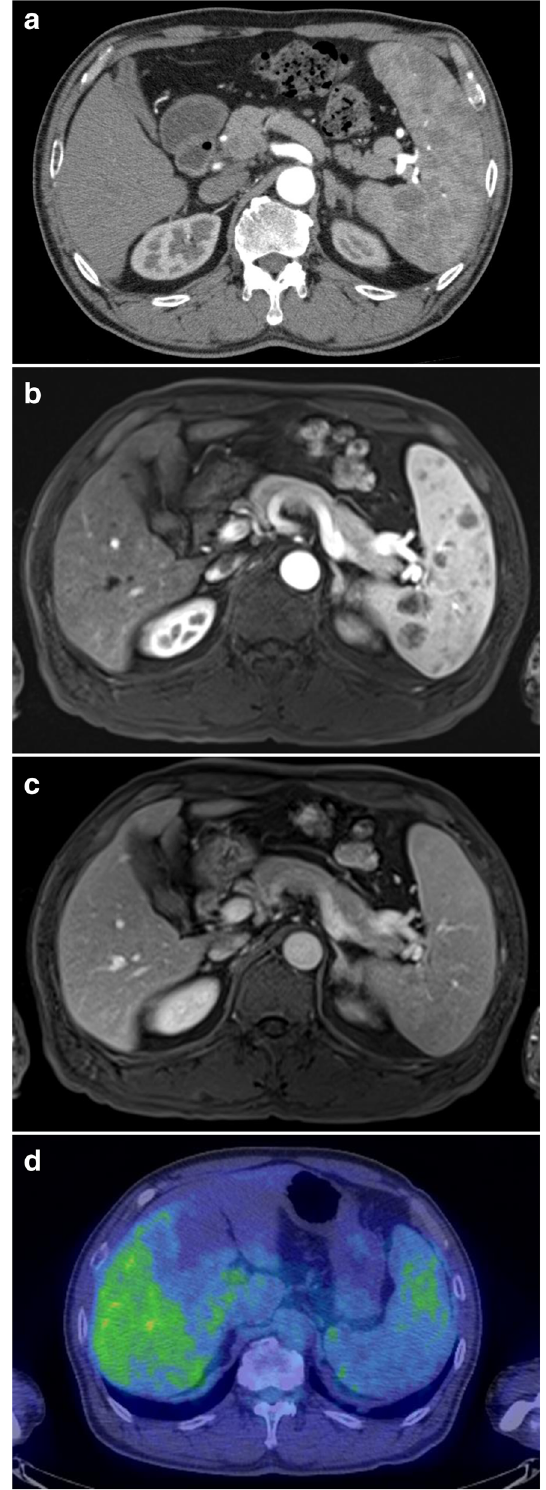
Fig. 3 a Macroscopic findings. A specimen showing splenomegaly (spleen size, 20 × 14 cm; weight, 940 g) with several elastic soft mass lesions. b Microscopic pathology findings. Image shows an extensive collection of polymorphic foamy